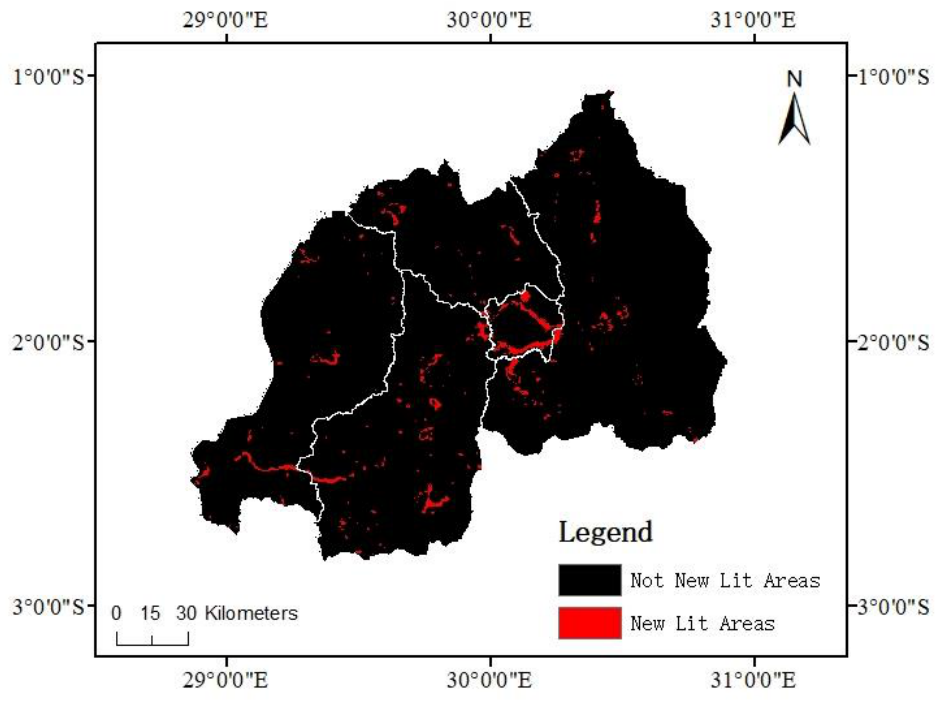
Figure 11. The new lit areas in Rwanda from 2012 to 2020.